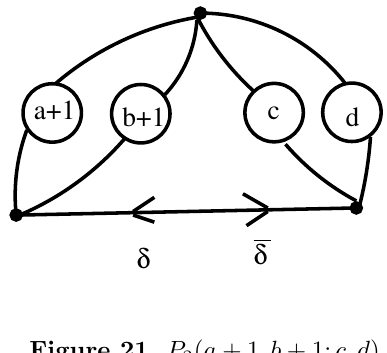
Figure 21 . P 2 ( a + 1 ; b + 1; c; d ).